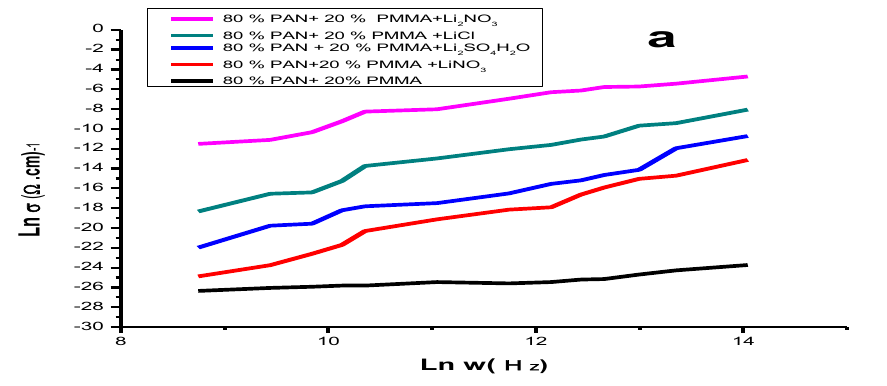
Figure 1 a: Variation of Ln σ (ω) with Ln(ω) for (80%PAN/20%PMMA) and doped with a.c